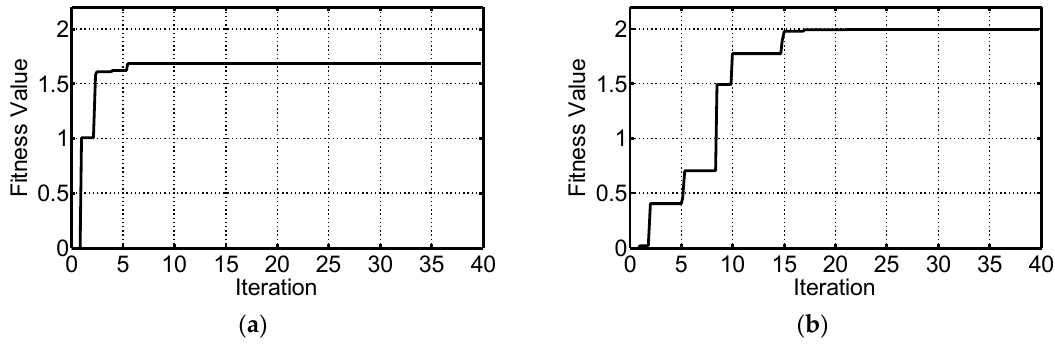
Figure 9. Evolutions of the fitness values optimized by ADE algorithm: ( a ) fitness values in Case 1; and ( b ) fitness values in Case 2.